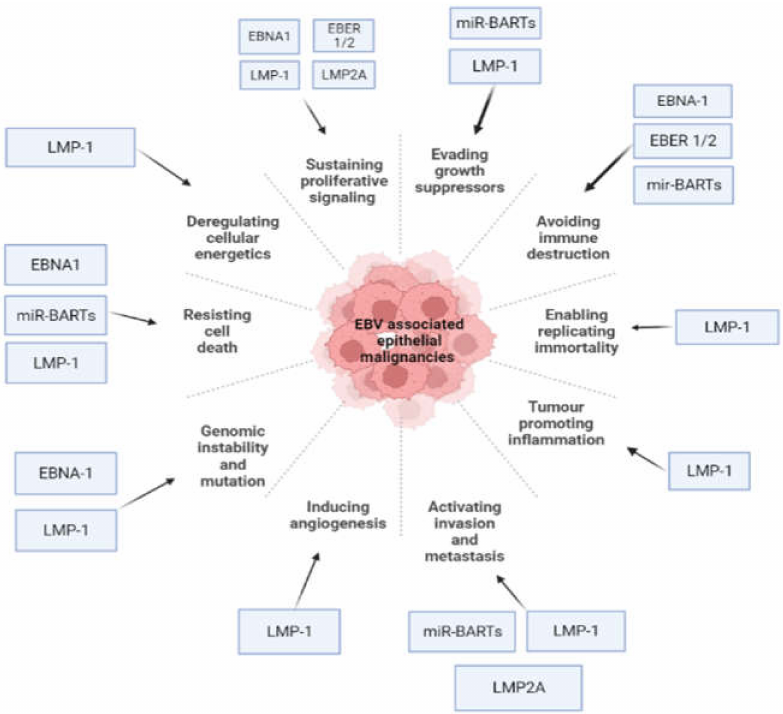
Figure 2. Epstein–Barr virus (EBV) latent genes target cancer hallmarks of epithelial malignancies (Image created by biorender.com, accessed on 23 January